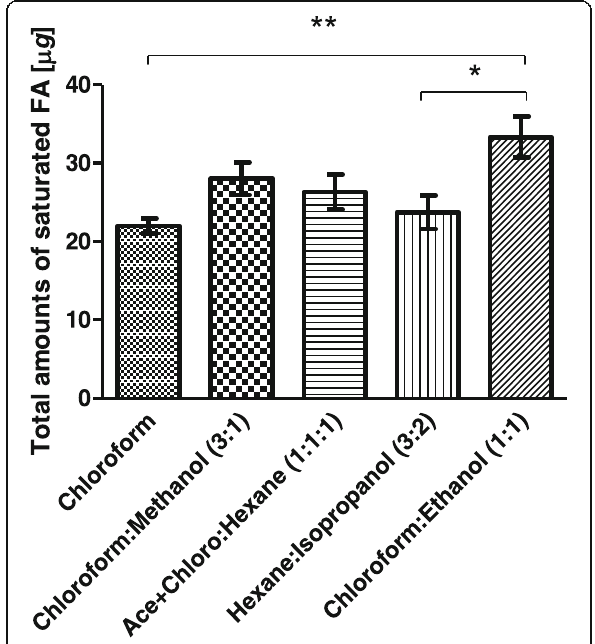
Fig. 5 Total quantity of saturated fatty acids by using different organic solvents ( μ g of total fatty acids). Data are represented as means ± SEM. The p value is 0.0044 ( n = 10, all donors). The two asterisks and one